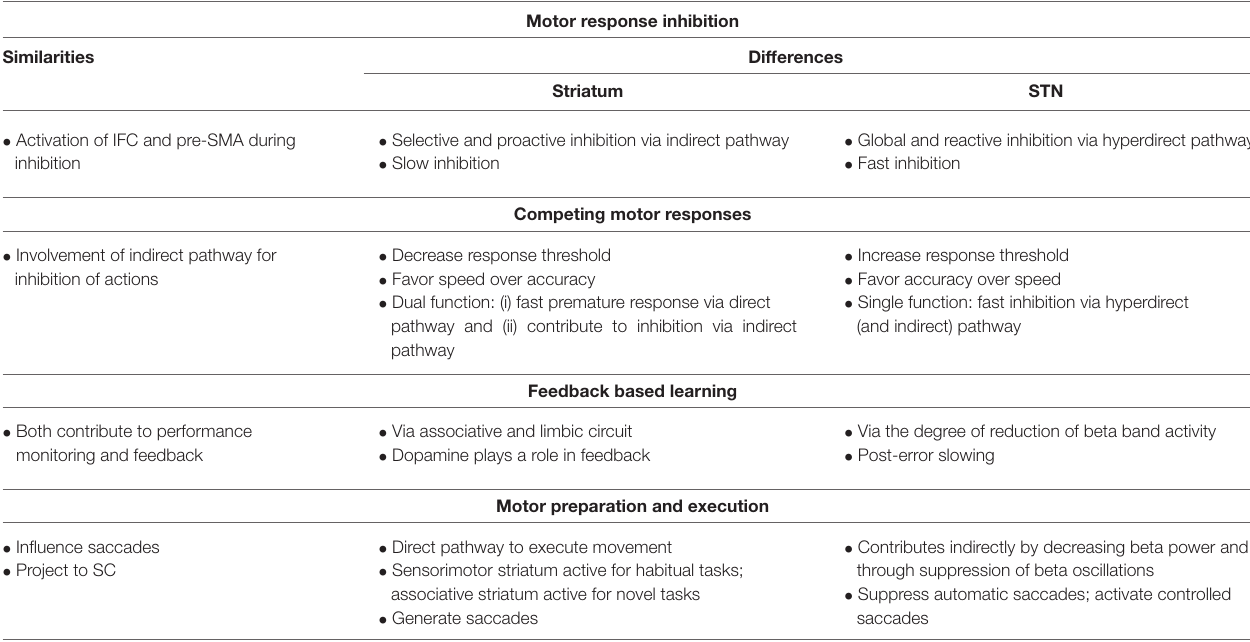
TABLE 2 | A summary of the similarities and differences between the striatum and subthalamic nucleus (STN) in four different tasks: motor response inhibition; competing motor programs; performance monitoring and feedback; and motor response planning and